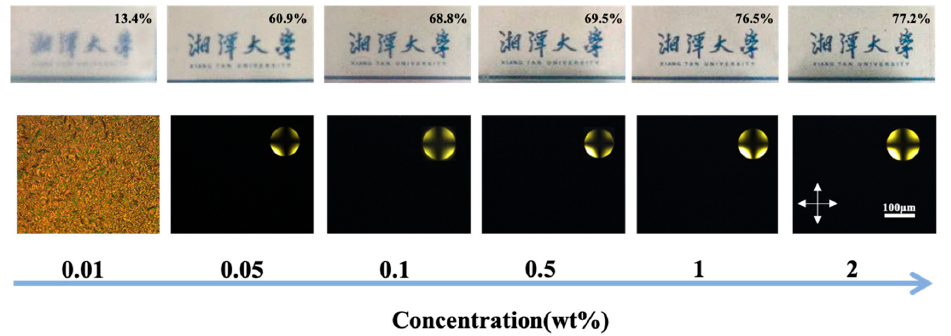
Figure 5. Images of the proposed PSLC cells with different CNT-PDB polymer brush concentrations and their corresponding POM images. Upper right corner: transmittance value at 550 nm.